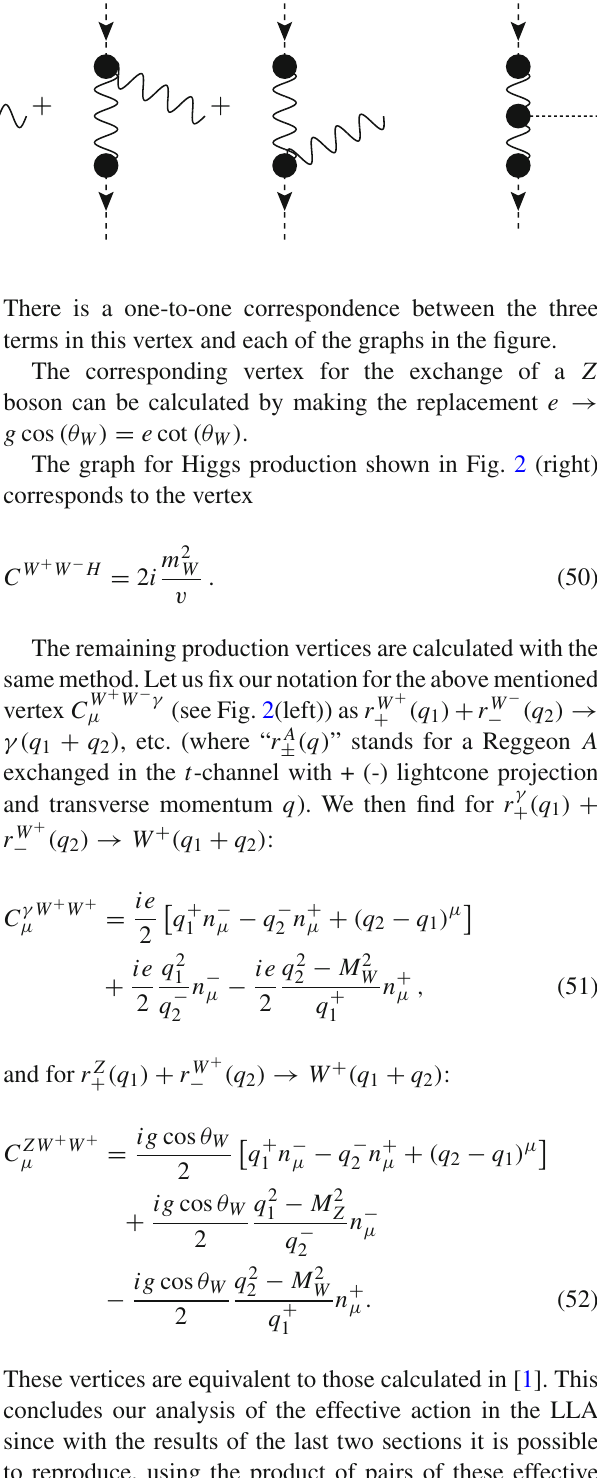
Fig. 2 Production of a photon or Z boson (left) and a Higgs boson (right) from a charged W vector